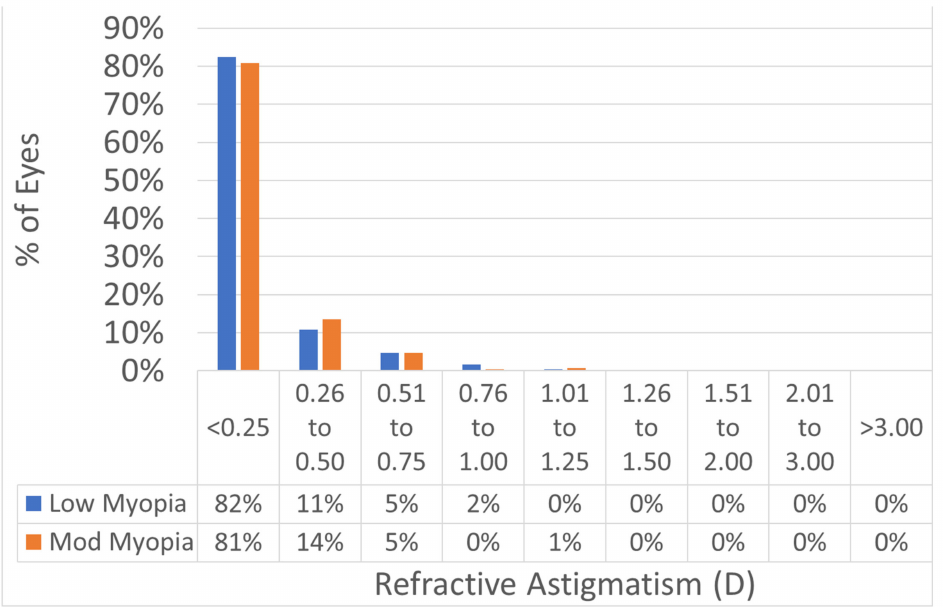
Figure 6. Postoperative refractive astigmatism. The predictability of the treatments was not different between the two myopic ranges. Postop refractive astigmatism was 0.32 ± 0.16 D in both groups ( p = 0.5). In 93% of the eyes in the low myopia group and 94% of the eyes in the moderate myopia group, the postoperative refractive astigmatism was within 0.5D from the intended target.